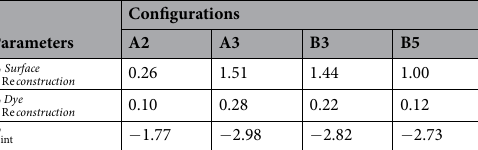
Table 2. The calculated reconstruction energies (in eV) for both dye and surface, and interaction energy of dye with the surface ( E int in eV) for selected adsorption configurations of model